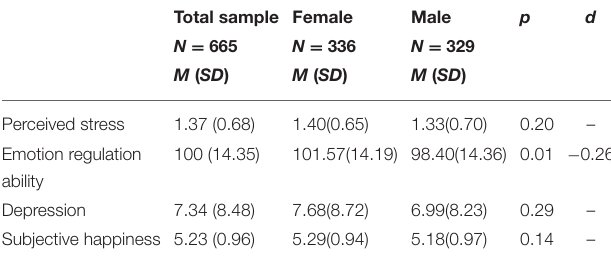
TABLE 1 | Gender differences in study variables.